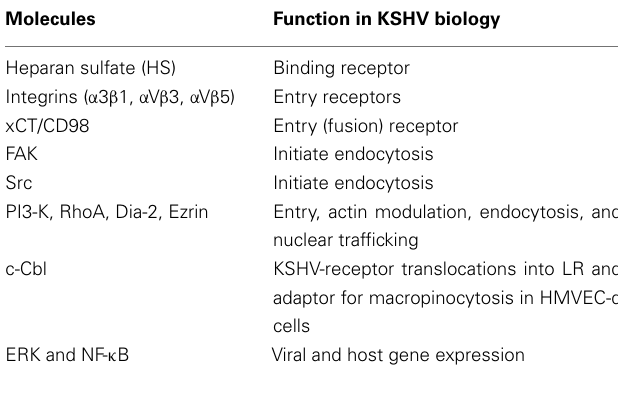
Table 3 | Host molecules and their roles in KSHV entry/infection in HMVEC-d and HFF